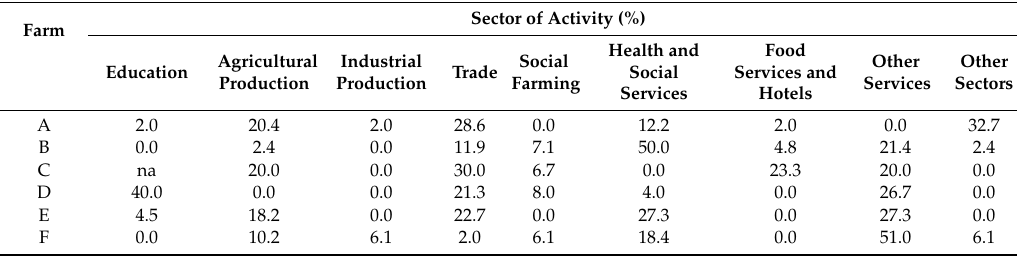
Table 3. The sector of activity of the nodes (time point: